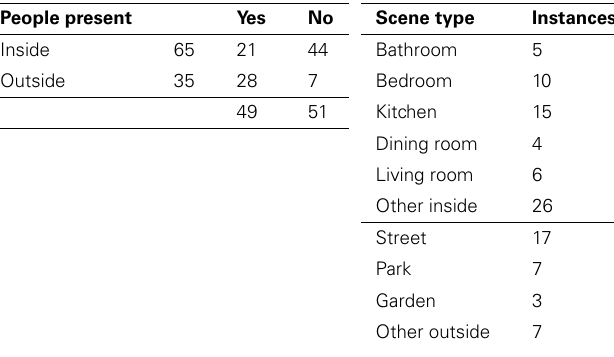
Table 1 | Overview of scene types